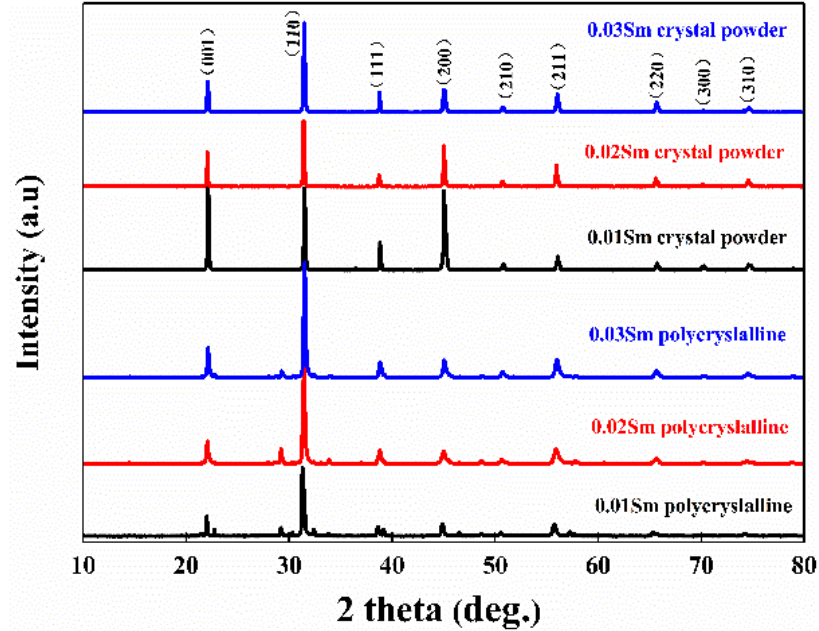
Figure 2. XRD patterns of the polycrystalline powder and the crystal powder.